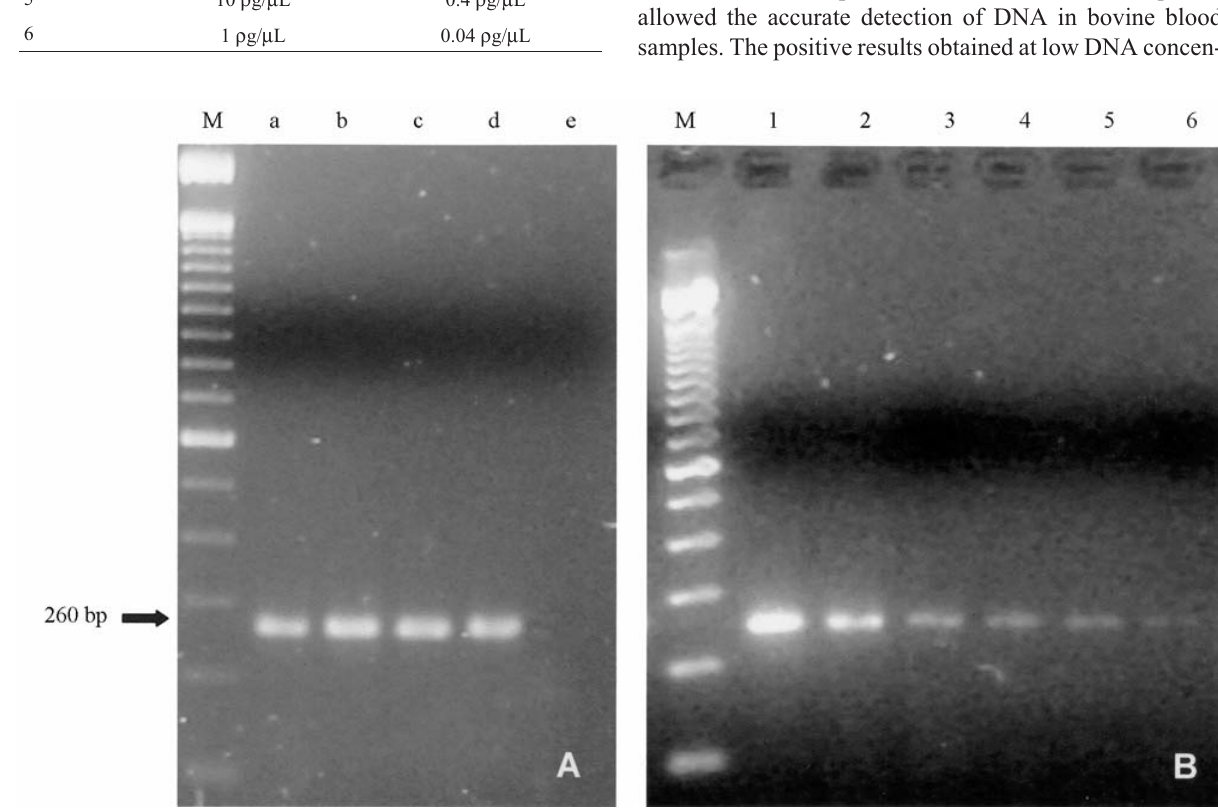
Figure 1 - (A) PCR amplification patterns of bovine DNA using TSPY -specific primers. The solid arrowhead indicates the 260 bp Y-specific sequence presentinNeloremales(a,b,c,d).ThissequenceisabsentinNelorefemales(lanee).Mindicatesmolecularweightmarker(100bpladder).(B)PCRam- plificationpatternsforvariousdilutionsofDNAfrommales.Thelanenumbering(1,2,3,4,5,and6)correspondstothedilutionsdescribedinTable1.